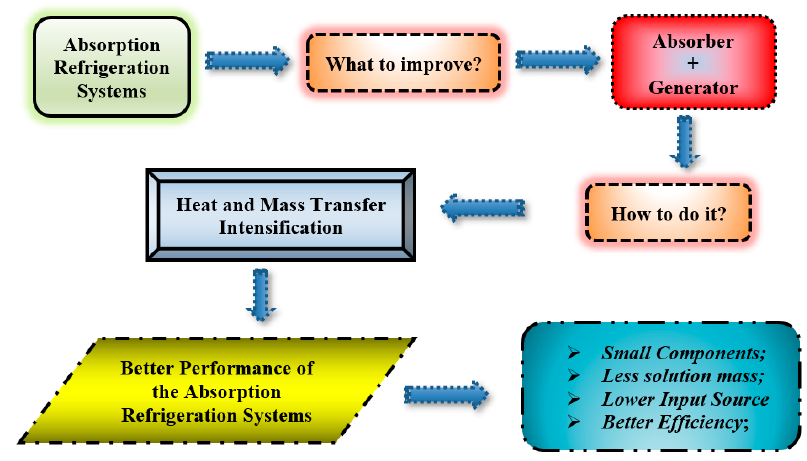
Figure 8. Flow chart of the way on the intensification on the heat and mass transfer.